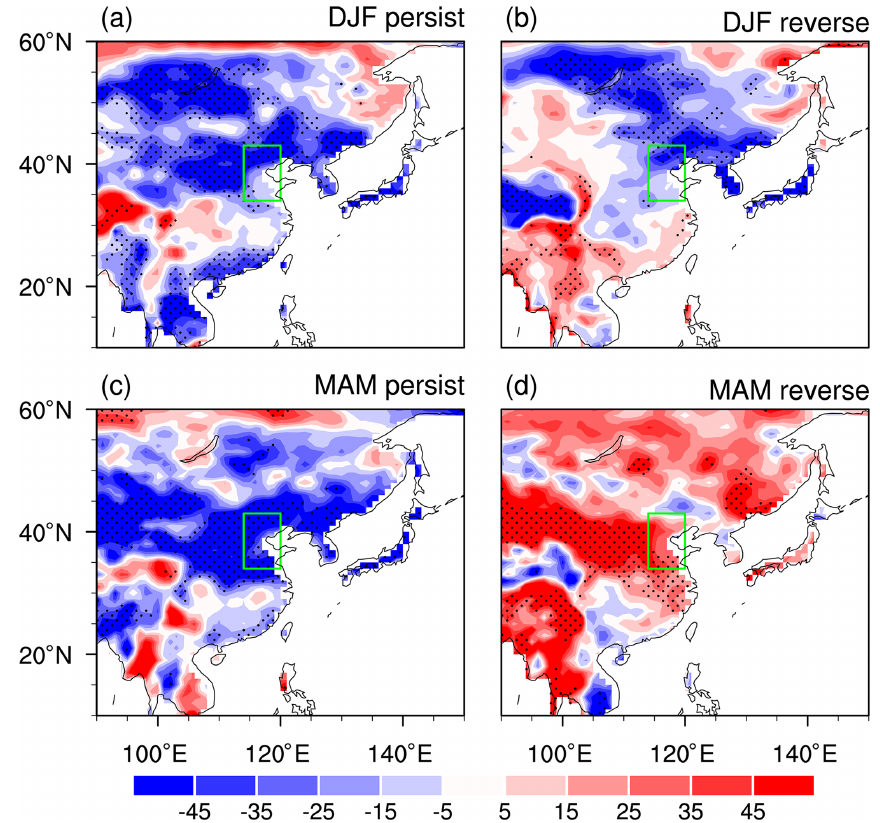
Figure 7. Composite anomalies of boundary layer height (BLH, unit m) in (a, b) winter and (c, d) spring in the (a, c) persistent years and the (b, d) reverse years. Stippled regions indicate anomalies that are statistically significant at the 5% level.